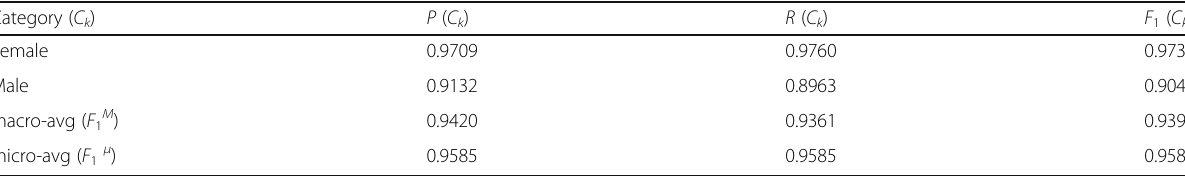
Table 5 Results with binary approach with cross validation = 10